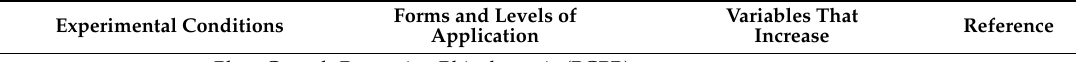
Table 9. Beneficial effects of PGPR and endophytic bacteria applications on some growth or quality variables of strawberry